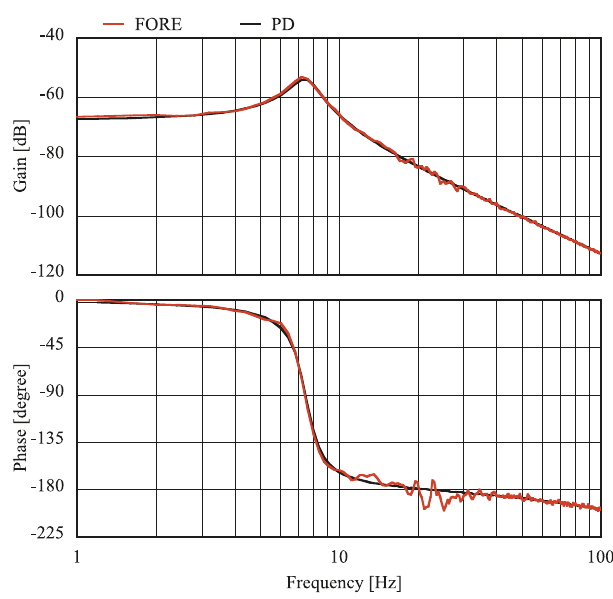
Figure 14. Comparison in frequency response between the FORE- and PD-controlled systems. The top represents the gain diagram. The bottom represents the phase diagram. FORE: red line; PD: black line.